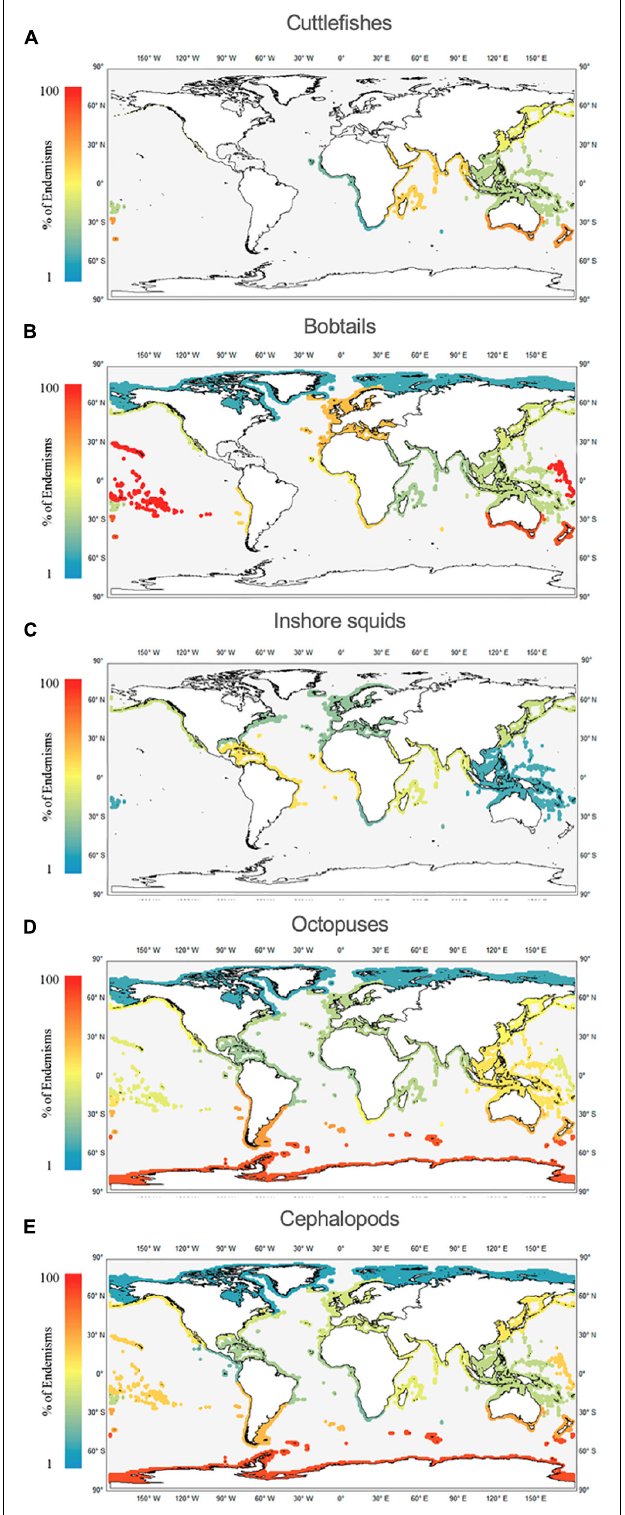
FIGURE 7 | Worldwide distribution of cephalopod endemisms (%) per realm, namely cuttlefishes (Family Sepiidae; A ), bobtails (Family Sepiolidae; B